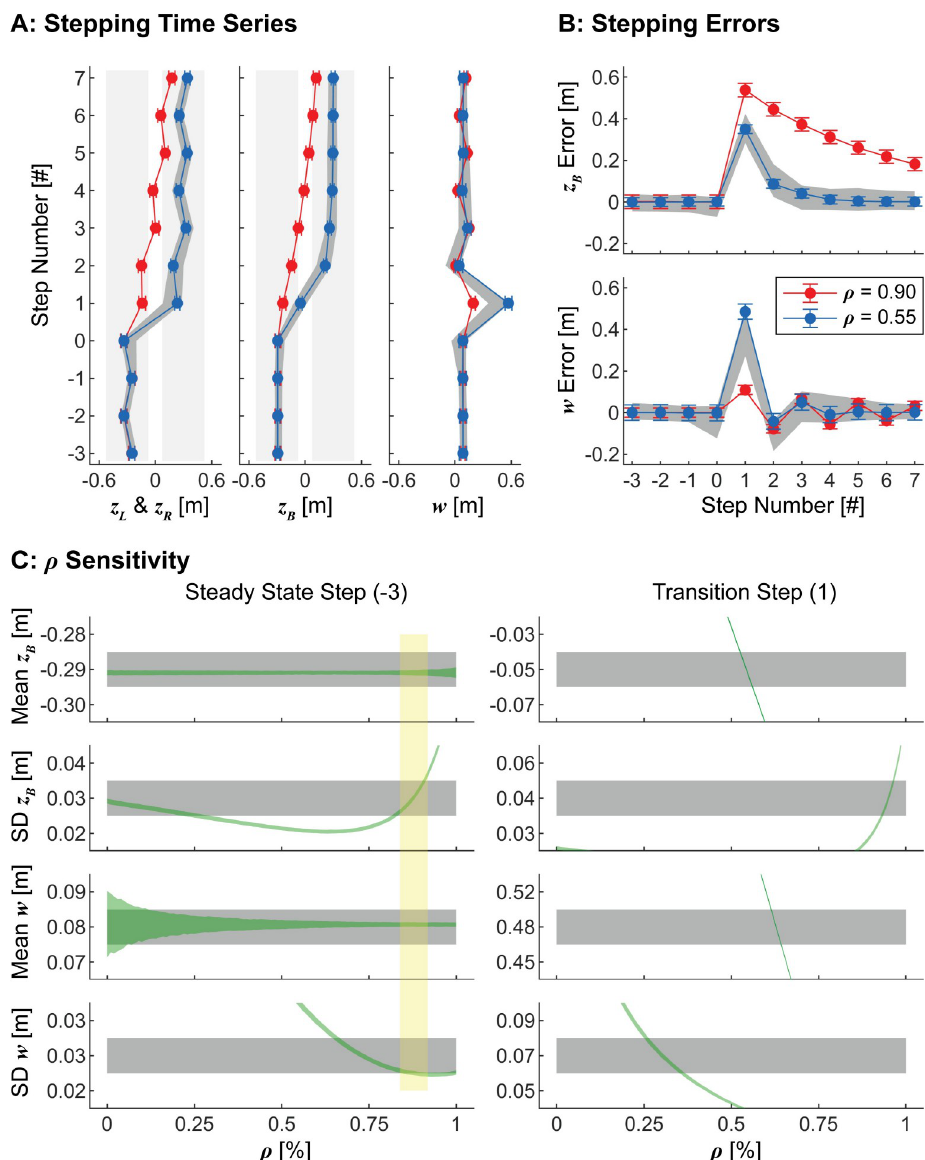
Fig 3. Constant Parameter Model Results. A) Simulated stepping time series (mean ± SD) of 1000 lateral transitions using the original, constant parameter model with ρ = 0.90 (red) and ρ = 0.55 (blue). For steps in the interval [–3, 0], � as the experimental mean z we set z during steady state walking before the transition. For steps in the interval [1,7], B B we set z B � as the experimental mean z B during steady state walking after the transition. For all steps, w � was defined as the experimental mean w during steady state walking. B) Stepping errors (mean ± SD) at each step relative to the stepping goals, [ z B � , w � ], for the same data as in (A). For both (A) and (B), gray bands indicate the middle 90% range from experimental data. C) Means and standard deviations of both regulated variables ( z and w ) during a steady state B step (Step -3; left) and during the transition step (Step 1; right) for all values of 0 � ρ � 1. Gray bands indicate 95% confidence intervals from the experimental data computed using bootstrapping. Green bands indicate ± 1 standard deviation from 1000 model simulations at each value of ρ . Model simulations over the approximate range of 0.83 � ρ � 0.92 fell within the experimental ranges for all variables for steady-state walking (Step -3; Left), as indicated by the region highlighted in yellow. However, no such range captured the experimental data during the transition step (Step 1; Right).